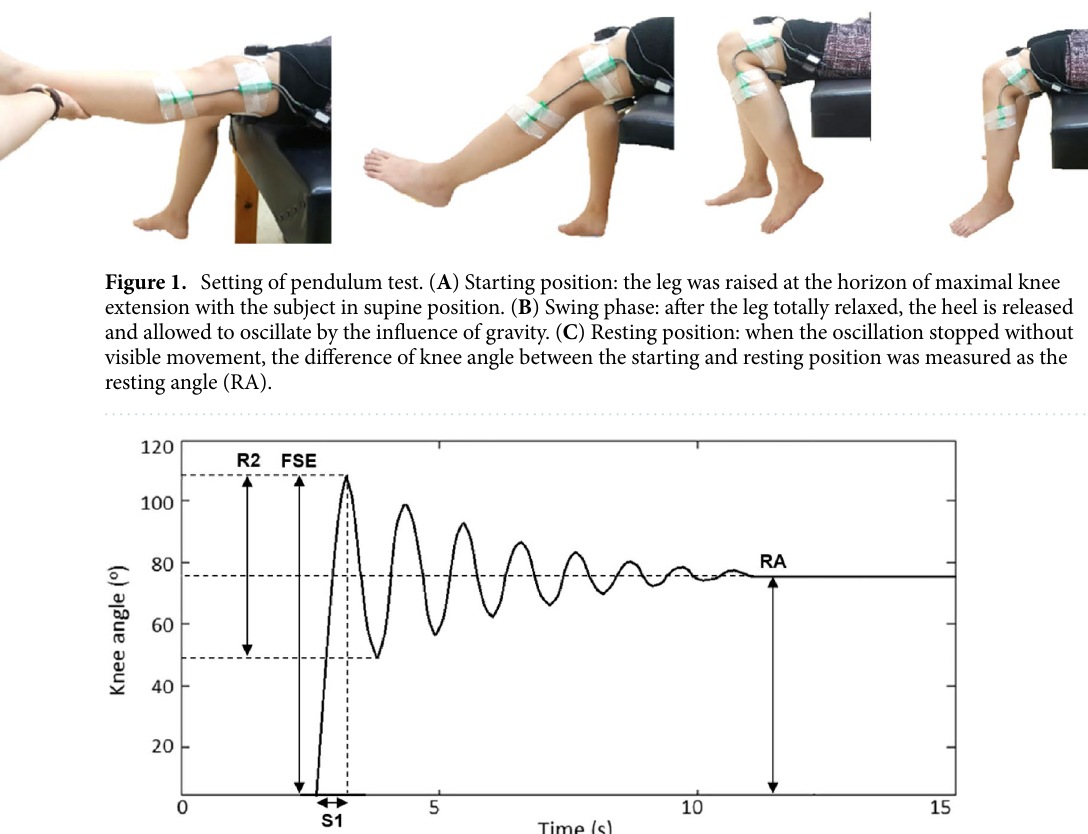
Figure 2. Oscillation of knee angle. A knee reaches the angle of first swing excursion (FSE) at time S1 and ended at the resting angle (RA) after several periods of oscillation. R2 is the angle of first extensive excursion. S1 is the duration of knee from the starting position to